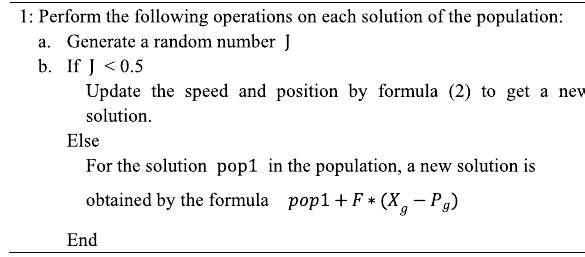
Algorithm 1. Cross-mutation algorithm